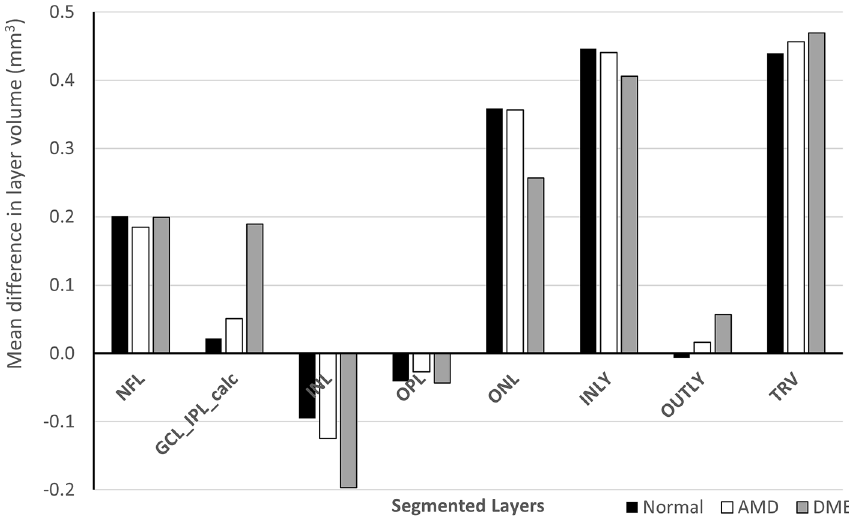
Figure 5. Mean difference between layer volumes measured by the proprietary and the cross-platform softwares expressed in mm 3 for different types of patients across different segmented